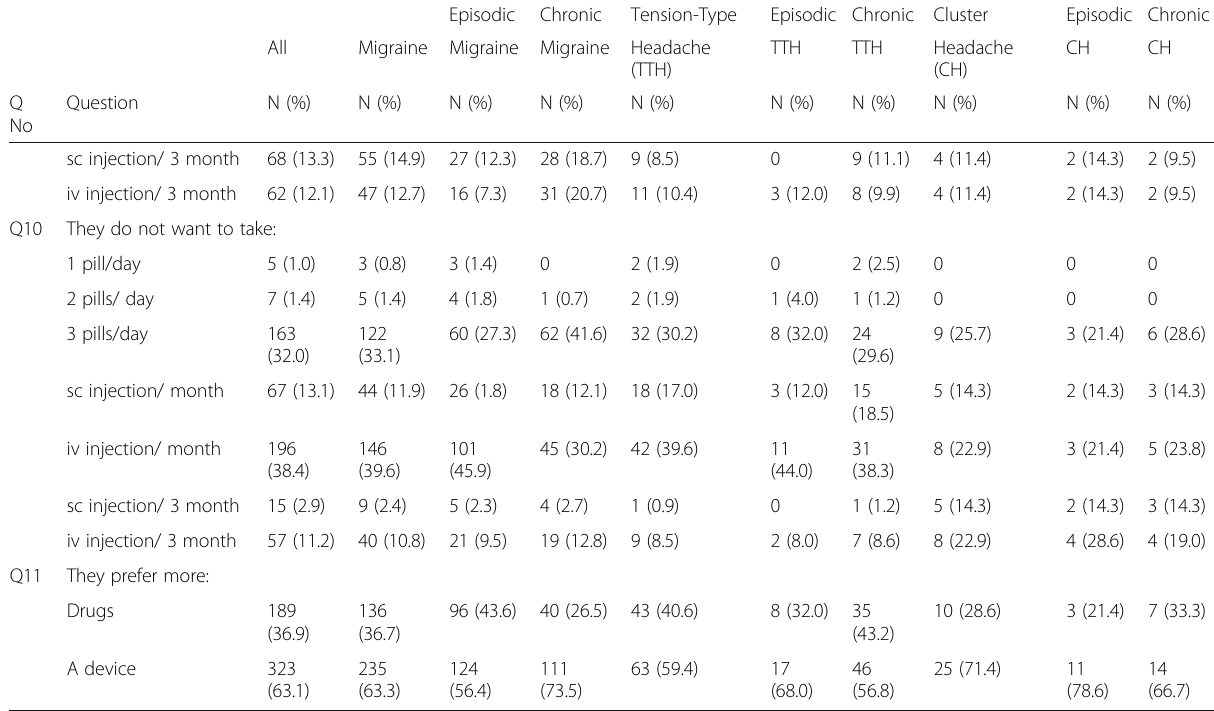
Table 2 Participants ’ preferences for headache treatment by primary headache disorder